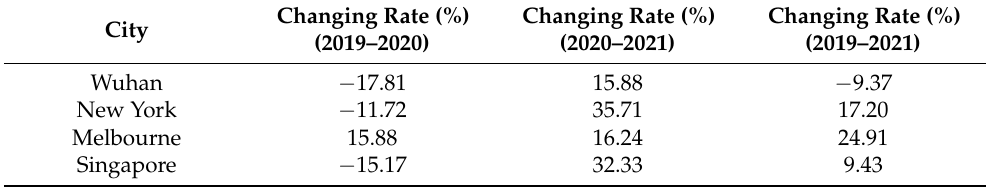
Table 4. Yearly (the first 26 weeks only) PM2.5 changing rates in four cities during lockdowns.